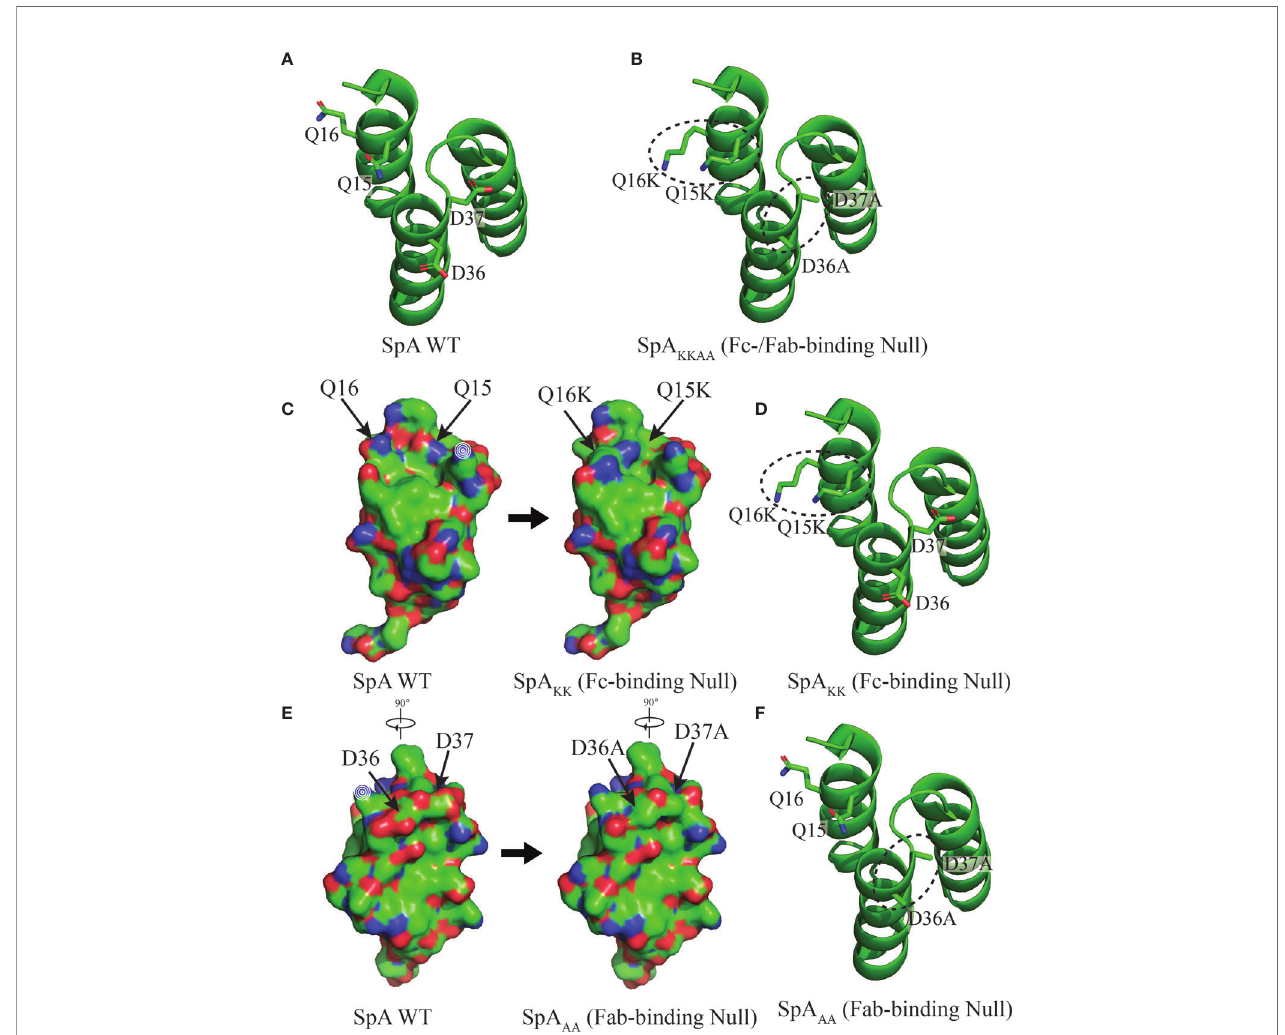
FIGURE 1 | Structure of Domain D of Staphylococcal protein A (SpA) WT and mutants. (A) Models of the structure of WT SpA with side chains of residues Q15, Q16, D36 and D37, shown with the peptide backbone that forms a triple alpha helical bundle. (B) SpA KKAA contains both sets of mutated residues, Q15K, Q16K, D36A and D37A to form a mutant with both Fab and Fc binding interactions abrogated. (C) Residues Q15 and Q16, that contribute to the Fc binding interaction (40, 46) and are mutated, Q15K and Q16K, to form the SpA KK mutant with abrogated Fc binding. Little or no effect on protein folding is predicted. Mutated residues are indicated with arrows and changes in surface exposure are shown between the WT structure at left and with residue mutations Q15K and Q16K at right. (D) Peptide backbone with mutated Q15K and Q16K residues circled. (E) Residues D36 and D37 that contribute to the Fab-binding interactions (34). Mutations D36A and D37A, form the SpA AA mutant with abrogated Fab-binding. Little or no effect on protein folding is predicted. Mutated residues are indicated with arrows and changes in surface exposure are shown between the WT structure at left and with residue mutations D36A and D37A at right. (F) Peptide backbone with mutated D36A and D37A residues circled. Modelling depiction generated with PyMOL (ref) using PDB: